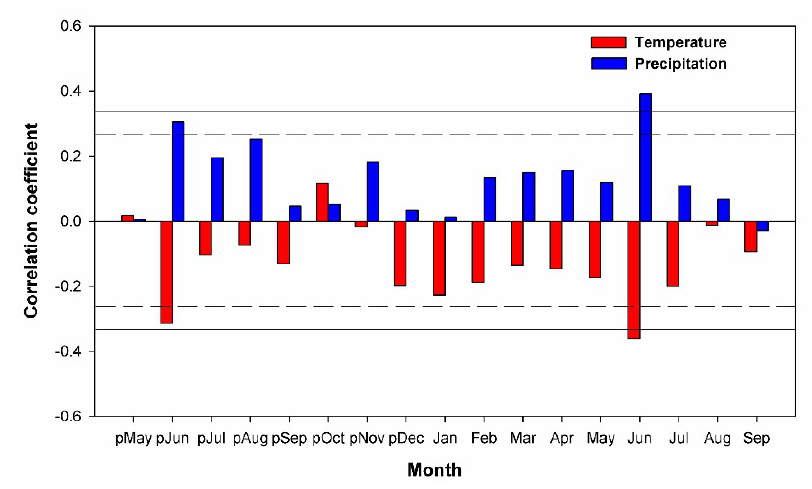
Figure 3. Correlations of the standard master chronology with monthly mean temperature (red bars), monthly total precipitation (blue bars) during the period of 1965–2016. The solid line and dashed line indicate p < 0.05 and p < 0.01, respectively.